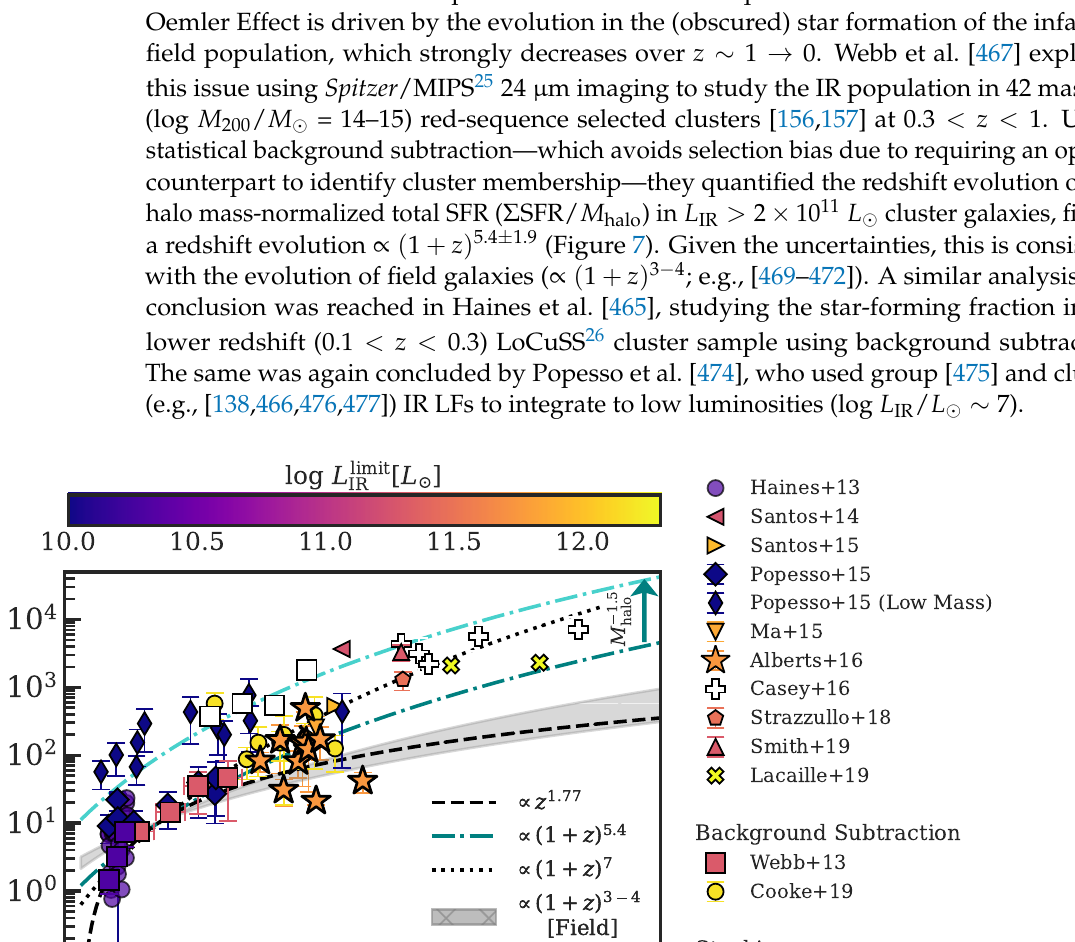
[467], see text halo